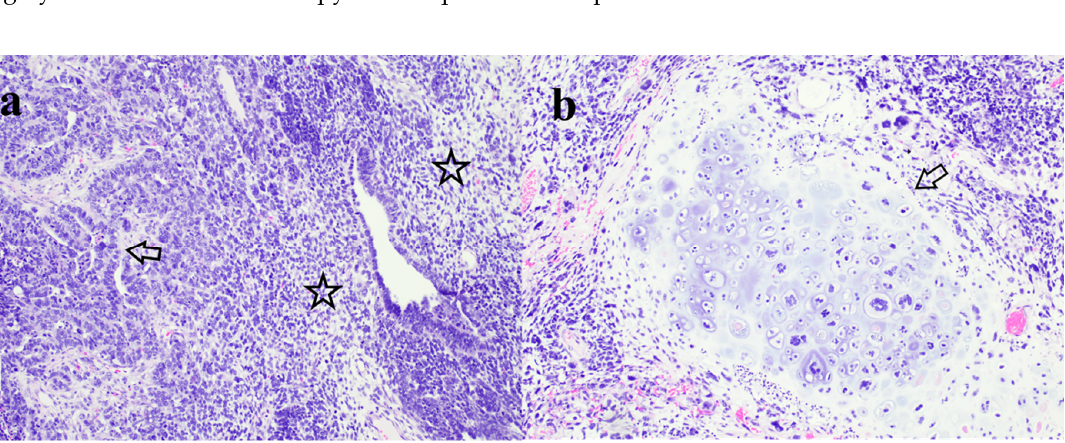
Figure 1. Malignant mesodermal mixed tumor (carcinosarcoma) of the ovary. ( a ) Juxtaposed malignant epithelial (arrow) and mesenchymal (stars) elements of the tumor. Hematoxylin and eosin, original magnification × 100. ( b ) Focal malignant heterologous (chondroid) stromal differentiation (arrow). Hematoxylin and eosin, original magnification × 100.